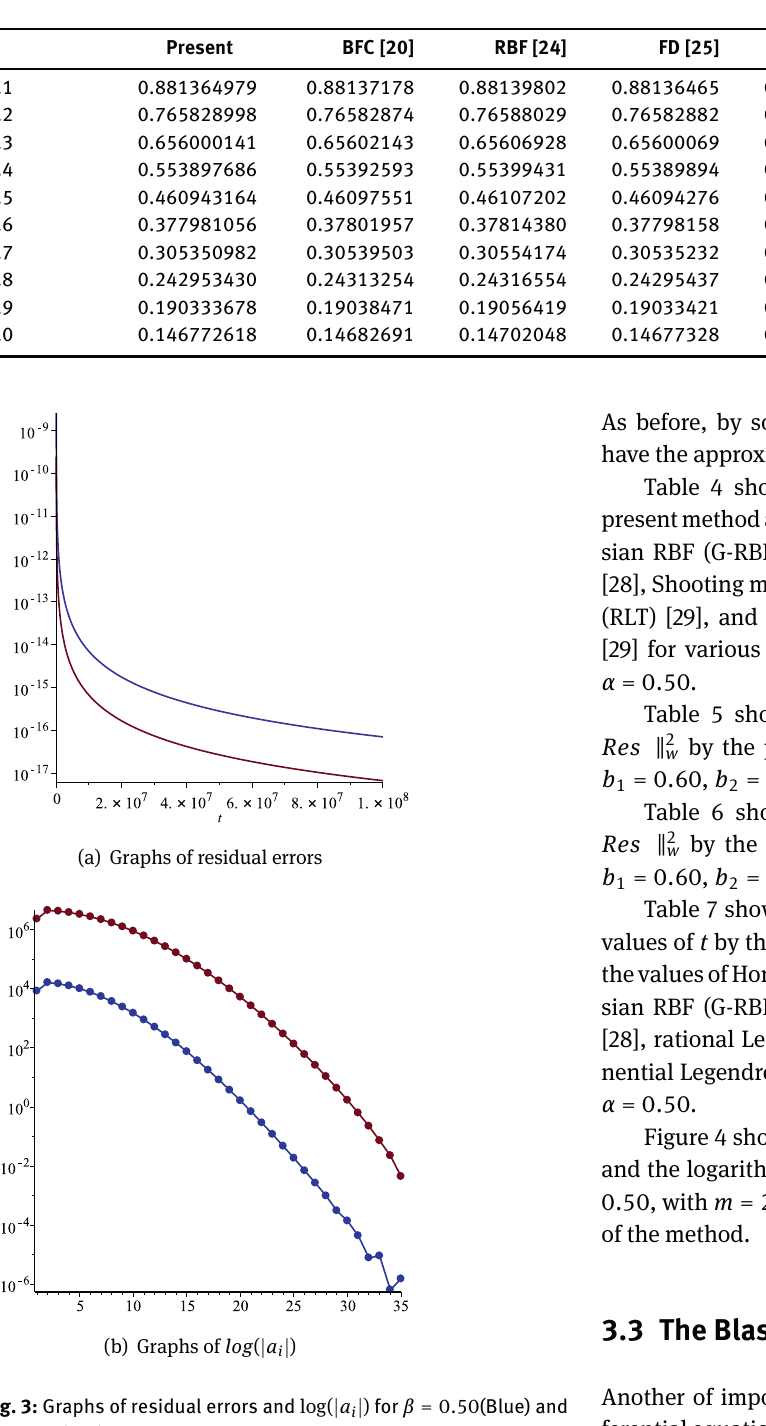
Table 3: Obtained values of y ( t ) for β = 0.5, α = 0.5, m = 35, and λ = 0.1755 , comparison between the present method, BFC [20], RBF